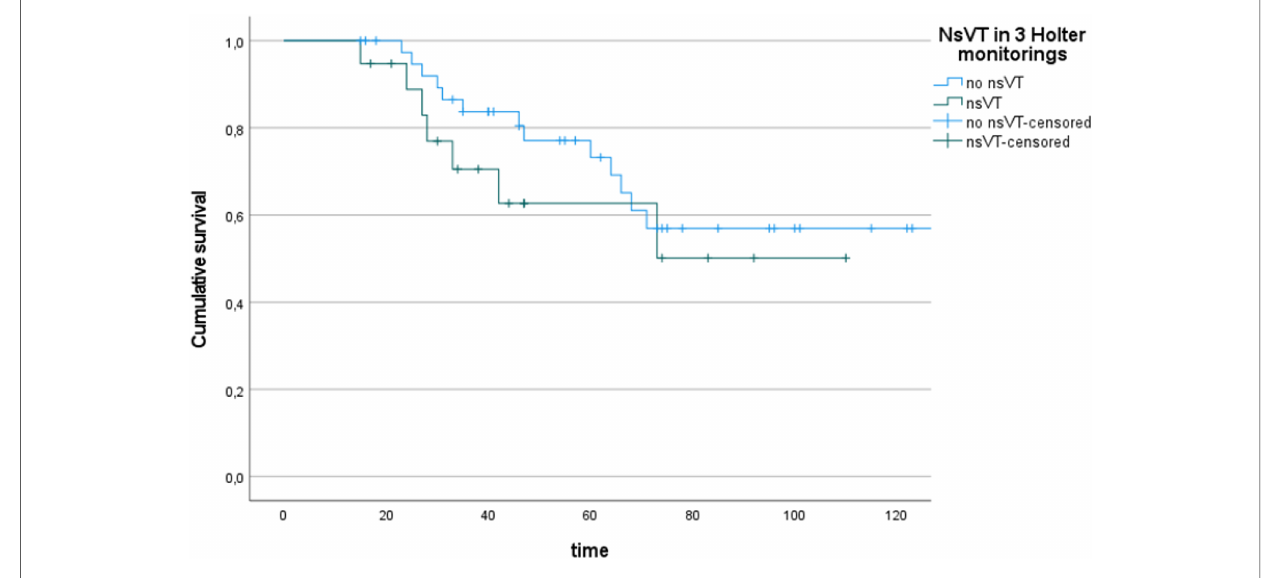
FIGURE 5 Kaplan – Meier plots (+=censored data) for survival of patients with sinus rhythm ( n =40) and non-sustained ventricular tachycardia (nsVT, n